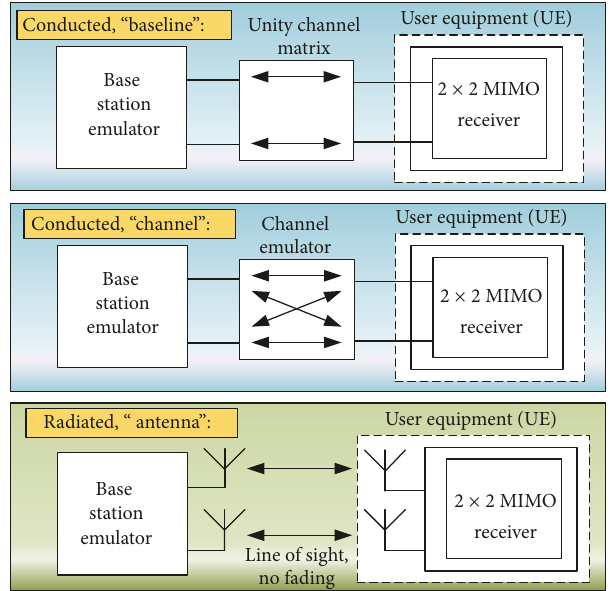
Figure 3: The split measurements: “baseline” and “channel” mea- surement have to be executed with the conducted setup , while “radiated” measurements employ the radiated setup